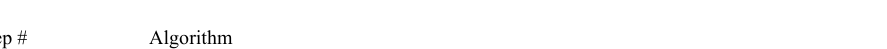
Table 2. WP-SVM Algorithm